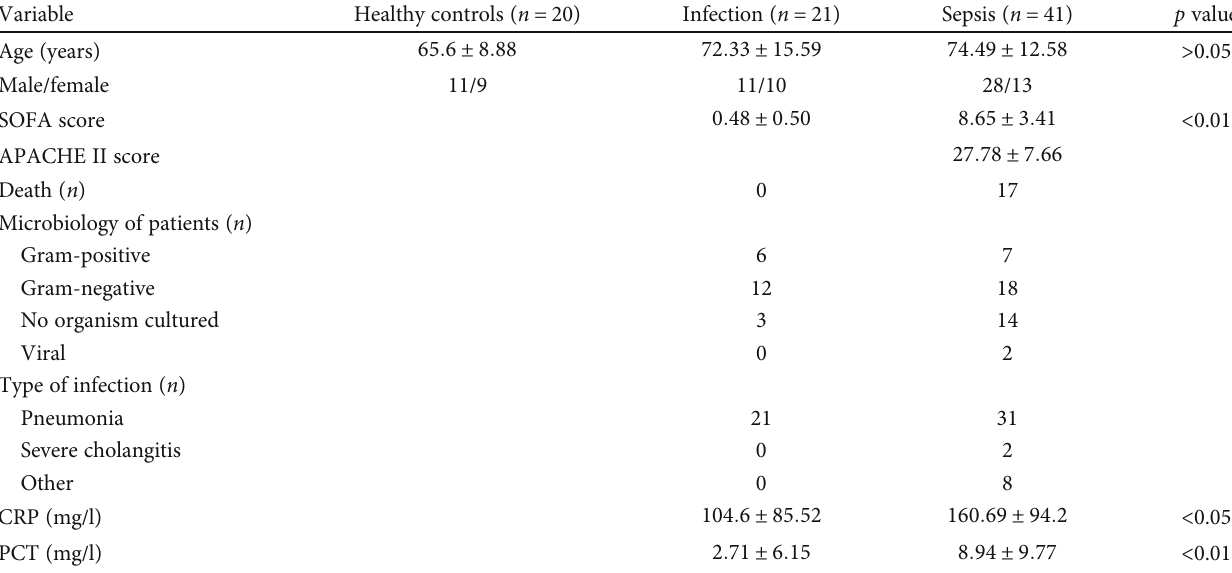
Table 1: Demographic and clinical characteristics of sepsis